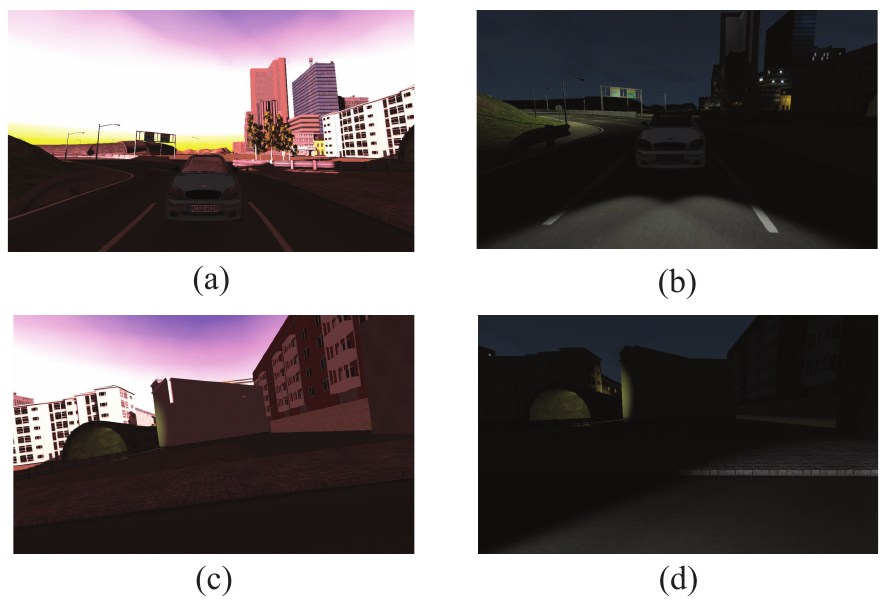
Figure 1. A difficult scene in the SYNTHIA dataset for the Visual Place Recognition (VPR) problem. Subfigures ( a – d ) are taken from one place in different views, when they have different appearance (e.g., illumination, weather or seasonal change, or all), or both: Viewpoint changes between subfigures (a–d). Appearance changes between subfigures (a–d). Viewpoint and appearance both change between subfigures (a,d), which is the most challenging